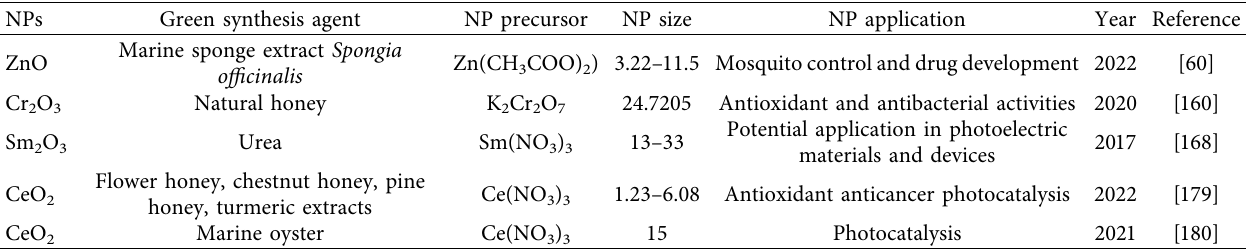
Table 4: Most important characteristics of nanoparticles synthesized using other green sources. NPs Green synthesis